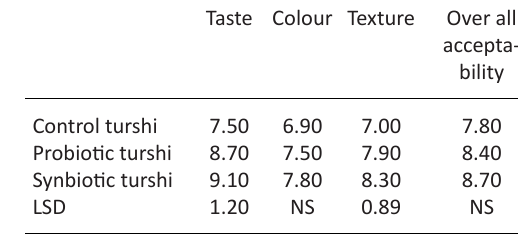
Table 3. Organoleptic Characteristics of Control, Probiotic and Synbiotic turshi samples pH